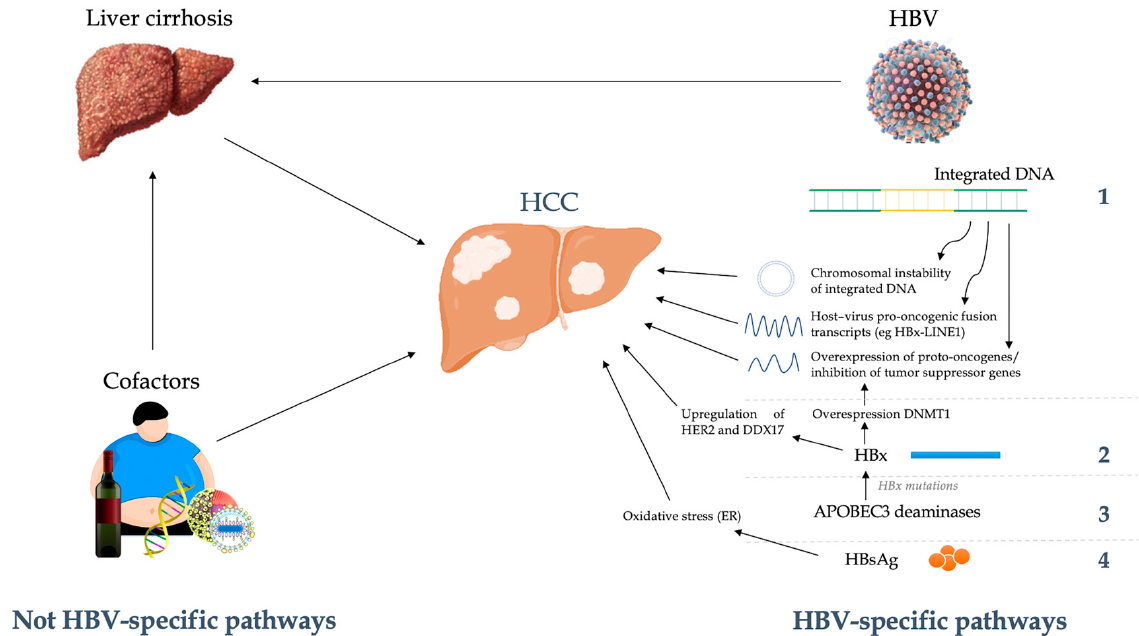
Figure 2. HBV and host interactions in hepatocarcinogenesis.